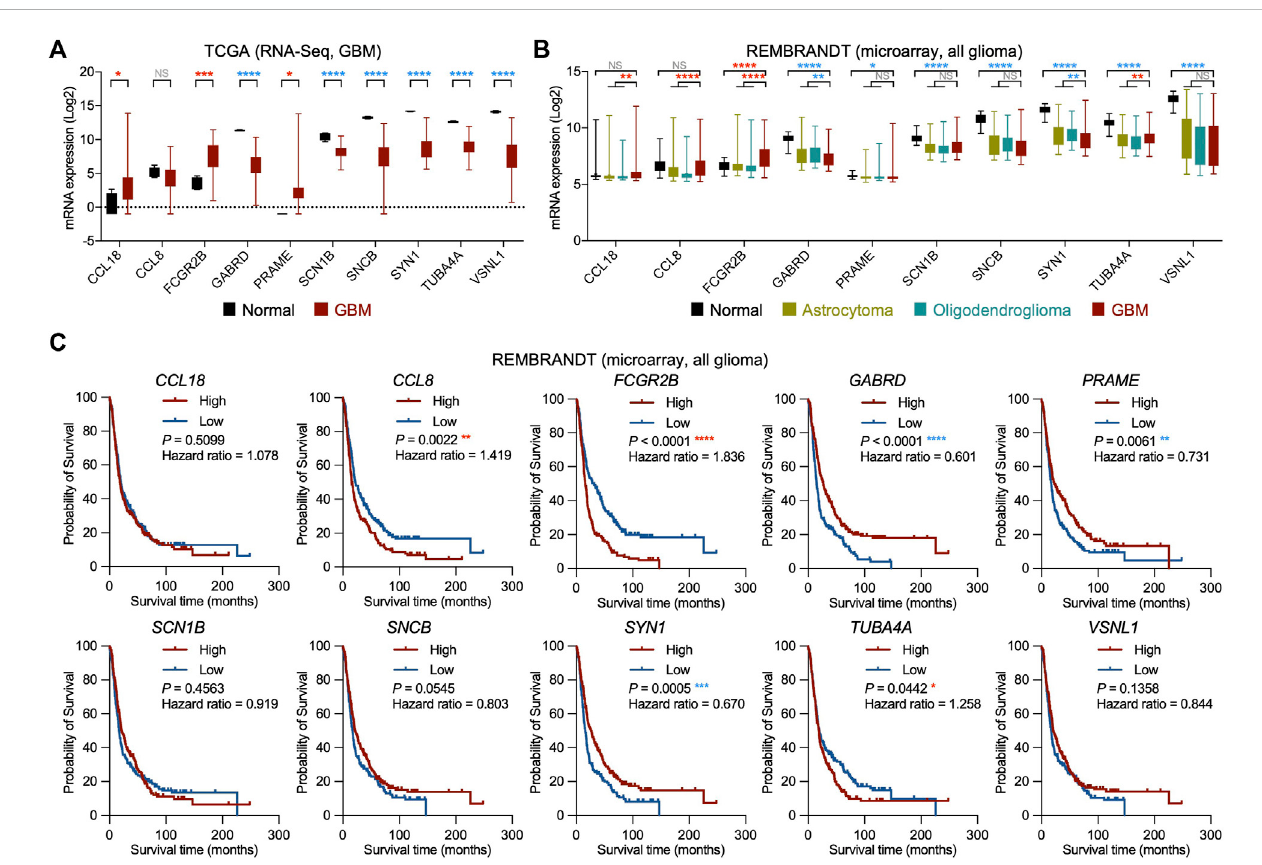
FIGURE 3 Validation of potential oncogenic regulators from recurrent GBM in other glioma cohorts. (A) Box plots showing the mRNA expression of the potential oncogenic regulator candidates in normal and GBM tissues from the TCGA cohort. Red asterisk, signi fi cantly higher in GBM; blue asterisk, signi fi cantly higher in normal. NS, not signi fi cant; * p < 0.05, *** p < 0.001, **** p < 0.0001. (B) Box plots showing the mRNA expression of the potential oncogenic regulator candidates in normal, astrocytoma, oligodendroglioma, and GBM tissues from the Repository of Molecular Brain Neoplasia Data (REMBRANDT) cohort. Red asterisk, signi fi cantly higher in GBM; blue asterisk, signi fi cantly higher in normal or low-grade glioma (LGG, including astrocytoma and oligodendroglioma). NS, not signi fi cant; * p < 0.05, ** p < 0.01, **** p < 0.0001. (C) Kaplan ‒ Meier survival analyses for all glioma patients with high and low mRNA expression of the potential oncogenic regulator candidates from the REMBRANDT cohort (n = 214, grouped by median value). Red asterisk, worse prognosis in high expression group; blue asterisk, worse prognosis in low expression group. * p < 0.05, ** p < 0.01, *** p < 0.001, **** p <